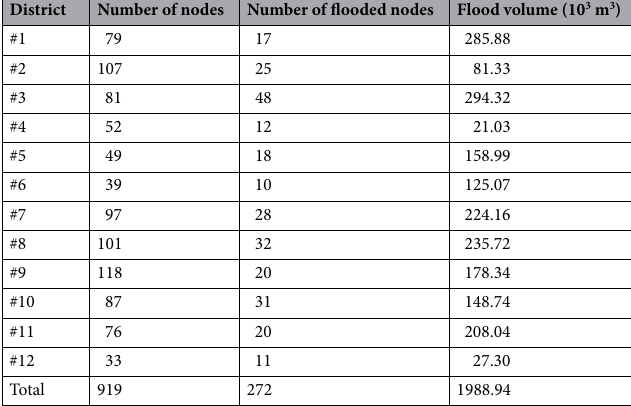
Table 4. The amount of flooding in different districts of Karaj.